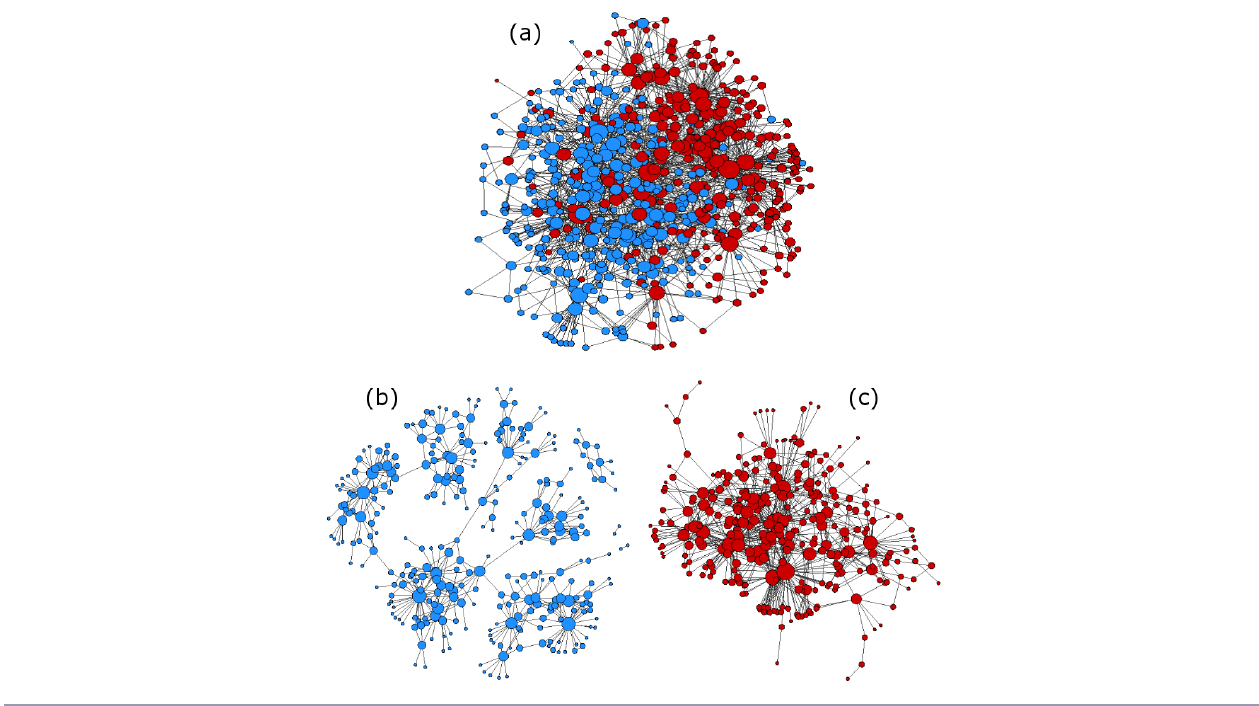
Fig. 2 . Networks analyzed in the study: (a) multilevel network of ties among local (blue) and regional (red) water governance actors in Central America, (b) network of within-level ties among local actors, and (c) network of within-level ties among regional actors. Nodes are sized by degree centrality, and isolates are removed from the local and regional network diagrams for improved